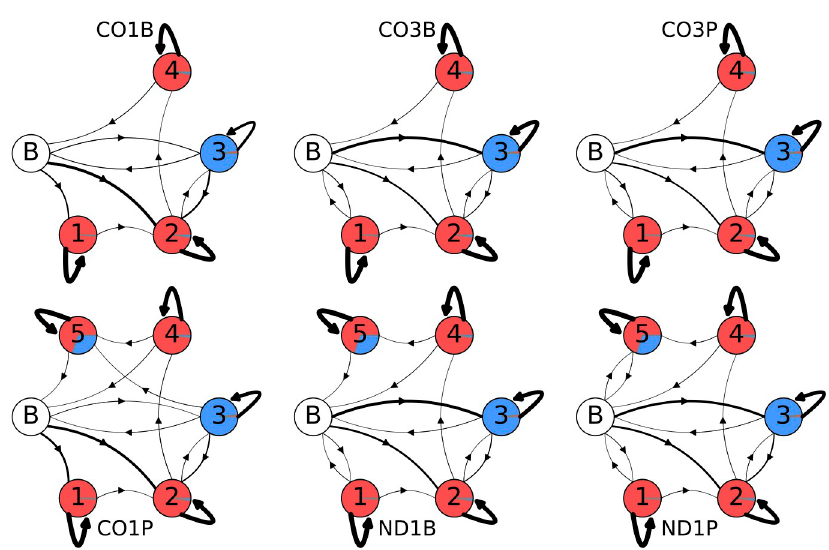
Fig 15. Post-training final models. Post-training model topologies and emissions for the best unstructured models for each tail dataset. The three models in the top row are in-tail only models, while the three bottom row models include ex-tails. The areas covered by the separate colors in each state circle are proportional to their emissions: uncolored circle labeled ‘B’ indicates the beginning/end state, red is a single adenine addition, and blue is a single uracil addition. Line thickness indicates transition probability, with thicker arrows indicating higher probability and thinner arrows indicated lower probability.